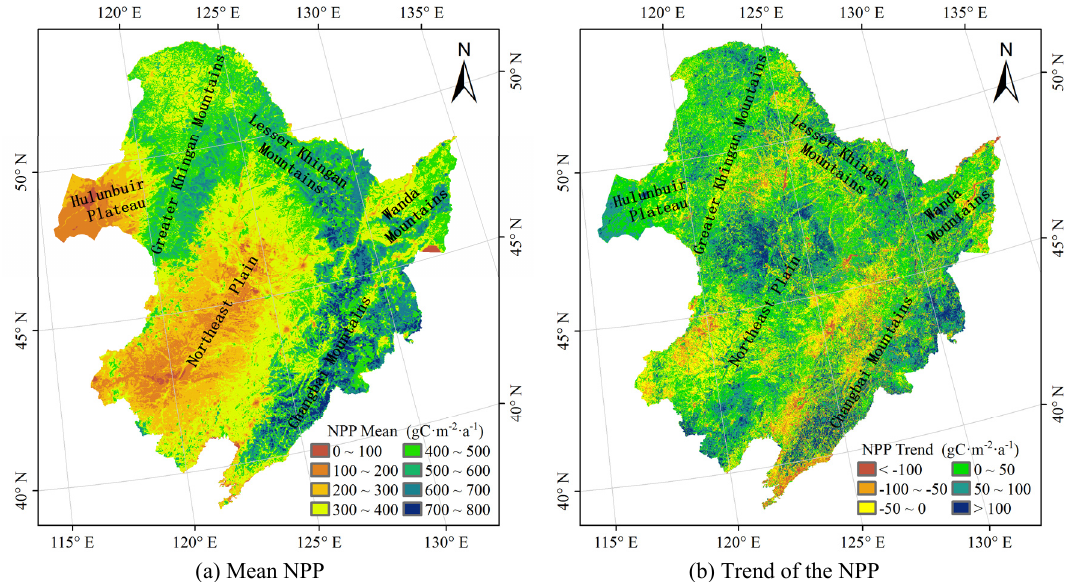
Figure 2. Spatial distribution of mean NPP and change trends in Northeast China from 2000 to